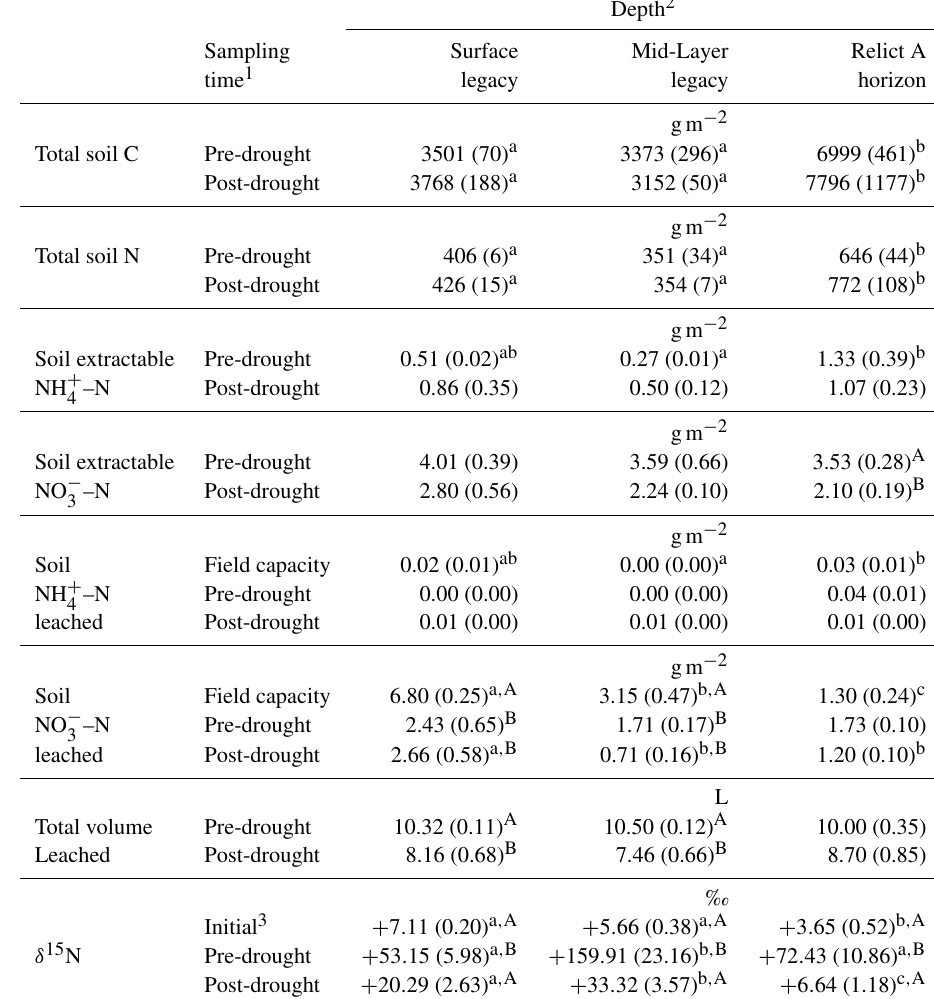
1 For a given sampling time, values with different superscript lowercase letters represent statistically significant ( P< 0 . 05 ) differences with depth. 2 For a given depth, values with different superscript uppercase letters represent statistically